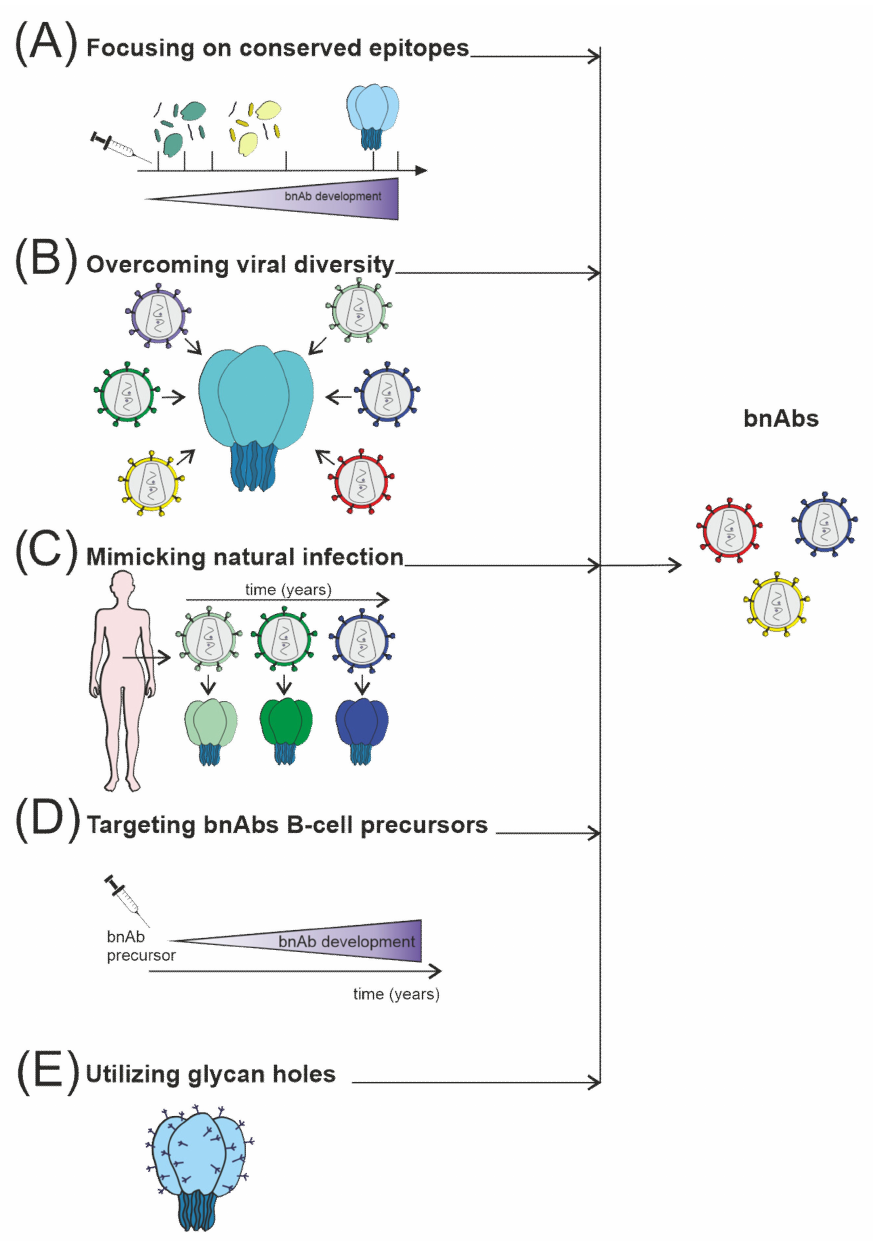
Figure 3. Several strategies are currently used to stimulate nAb responses towards bnAb generation, which consist of ( A ) directing of Ab response to conserved sites, for example, using fusion peptides; ( B ) use of mosaic or consensus antigens to overcome the viral diversity of circulating HIV-1 worldwide; ( C ) clonal immunogens resembling the evolution of the virus in HIV-1 infected individuals modeling natural infection; ( D ) targeting immunogens to putative bnAb germline progenitors, followed by immunization leading to the affinity maturation pathway to bnAb developm € ; ( E ) selective removing of glycans to focus Ab responses to a specific site of interest, such as CD4 binding site